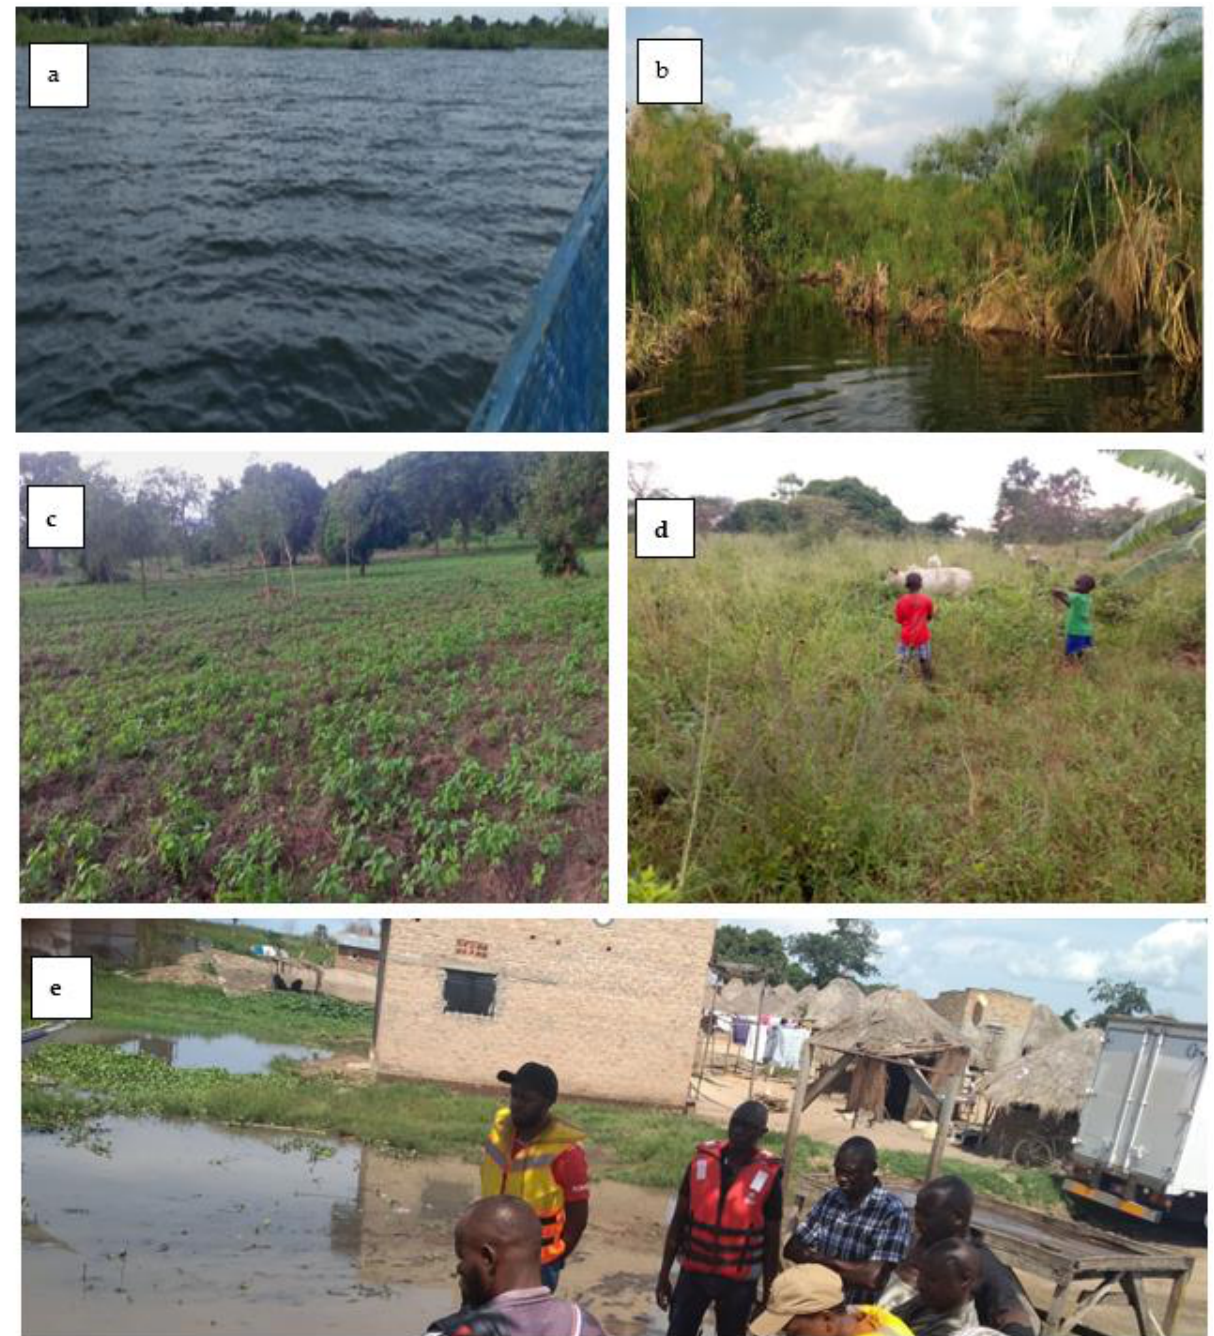
Figure 2. Typical setting of the LULC classes within L. Kyoga catchment (( a )-water, ( b )-wetland, ( c )- agricultural land, ( d )-rangeland, ( e )-settlement) . ( c )-agricultural land, ( d )-rangeland, ( e